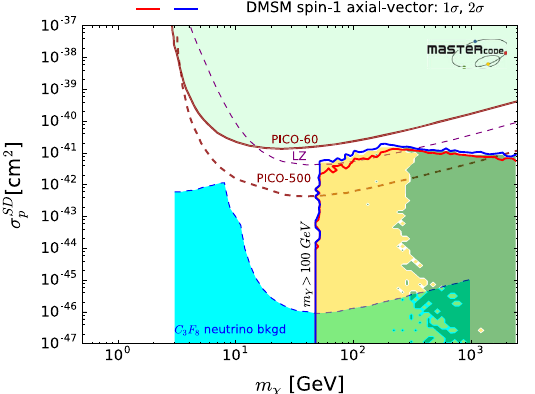
trino ‘floor’ applicable to an experiment such as PICO-500 that uses C 3 F 8 (shaded blue). Right panel: Contours of the likelihood function in the ( m χ ,σ SD n ) plane for the axial-vector model, showing the rescaled upper limit from the XENON1T experiment [80] and the prospective sensitivity of the LZ [100] experiment to σ SD n , as well as the neutrino ‘floor’ applicable to an experiment that uses Xenon (shaded